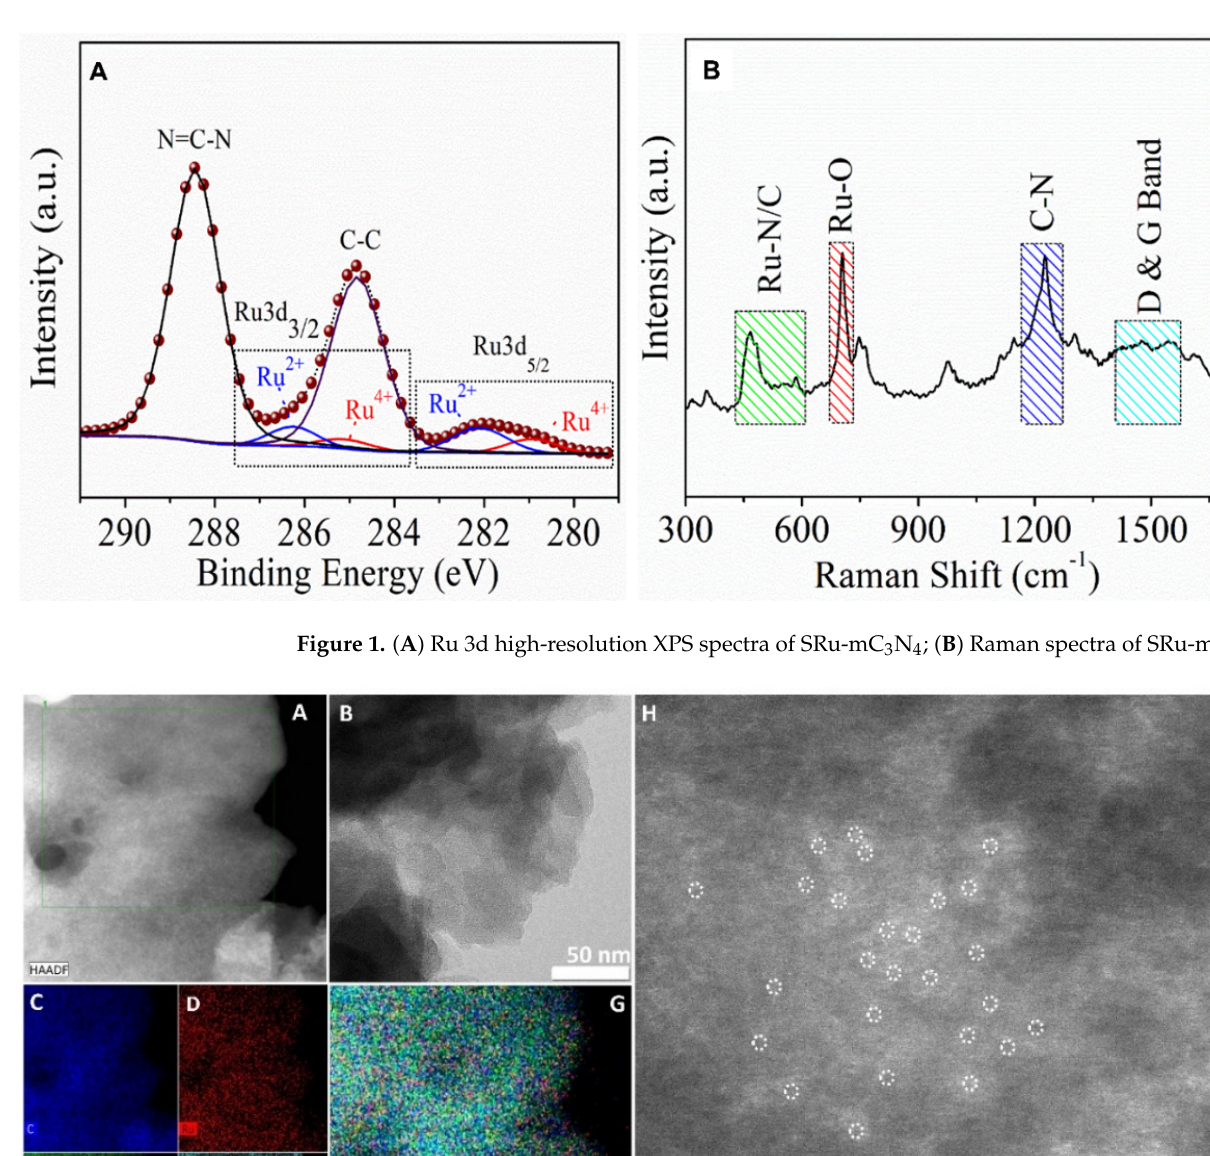
Figure 1. ( A ) Ru 3d high-resolution XPS spectra of SRu-mC 3 N 4 ; ( B ) Raman spectra of SRu-mC 3 N 4 .